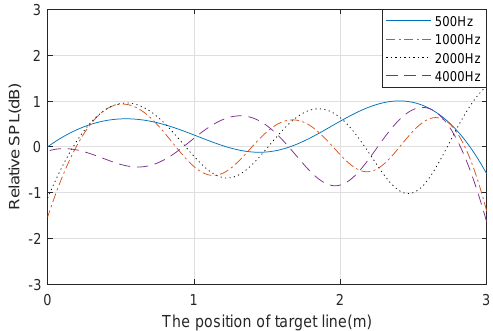
Figure 7. The relative SPL distribution of 500 Hz, 1000 Hz, 2000 Hz, and 4000